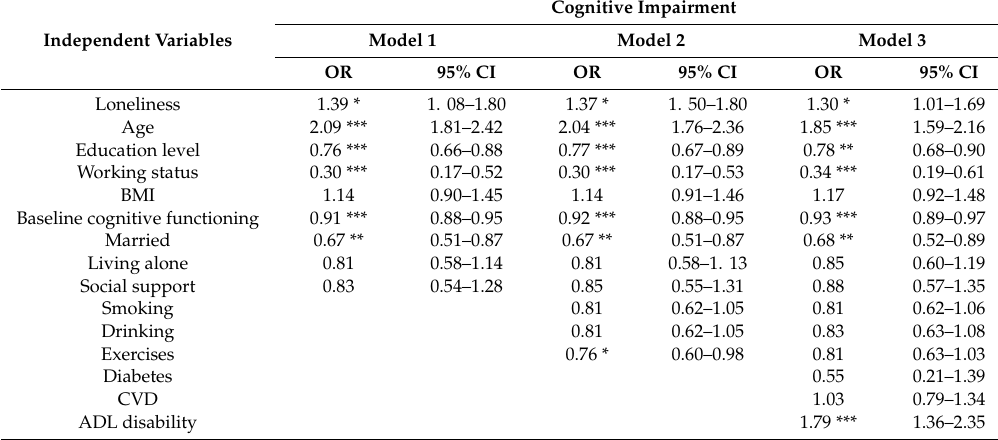
Table 2. Association between loneliness and cognitive impairment among men aged 65 or older.